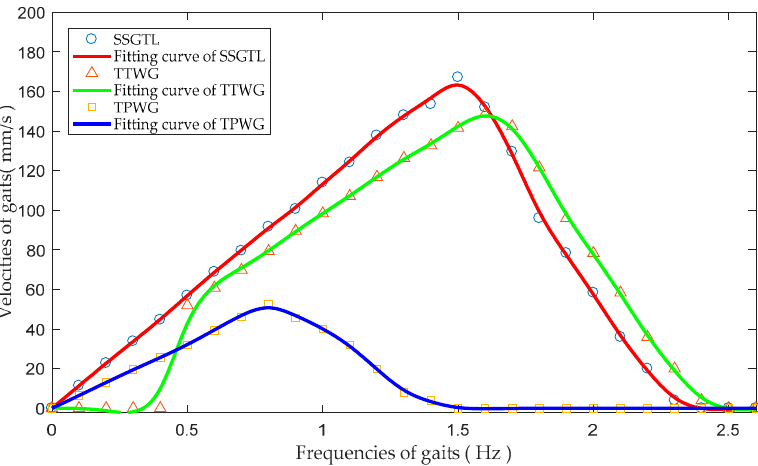
Figure 13. The velocities at different rotary angles of the horizontal servos.